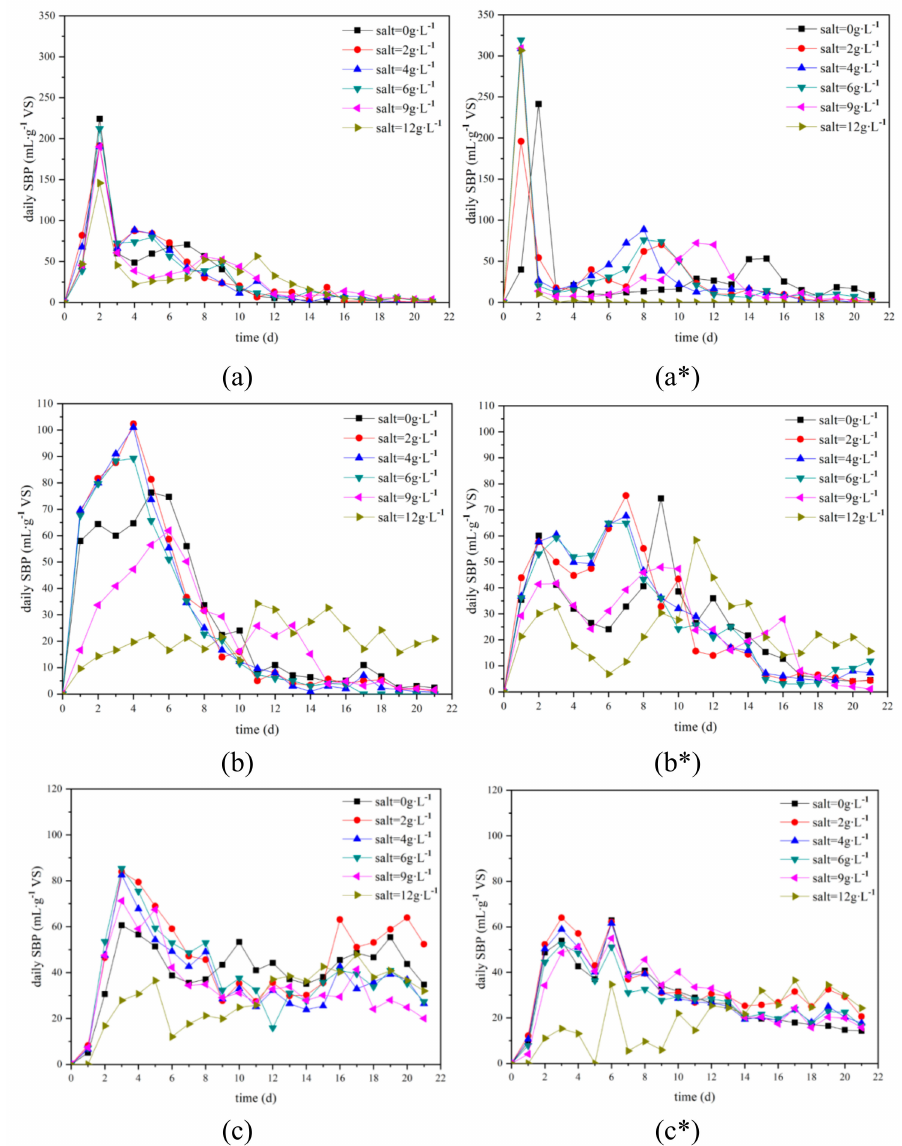
Figure 2. Daily specific biogas production of ( a ) HCFW, ( b ) HPFW, ( c ) HFFW with di ff erent salt additions under 5 (without *) and 8 (with *) gVS · L − 1